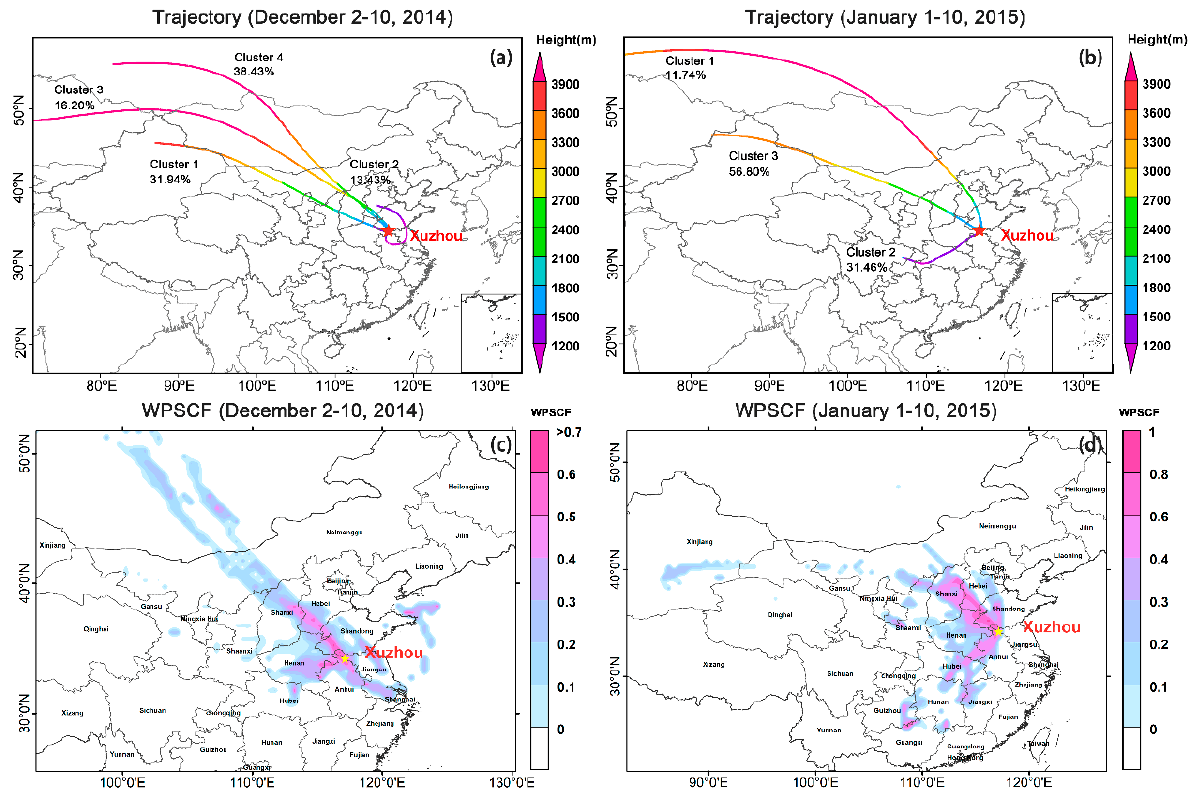
Figure 9. Mean 72 h backward trajectories at a 1500 m altitude and WPSCF in Xuzhou during 2–10 December 2014 ( a , c ) and 1–10 January 2015 ( b , d ).